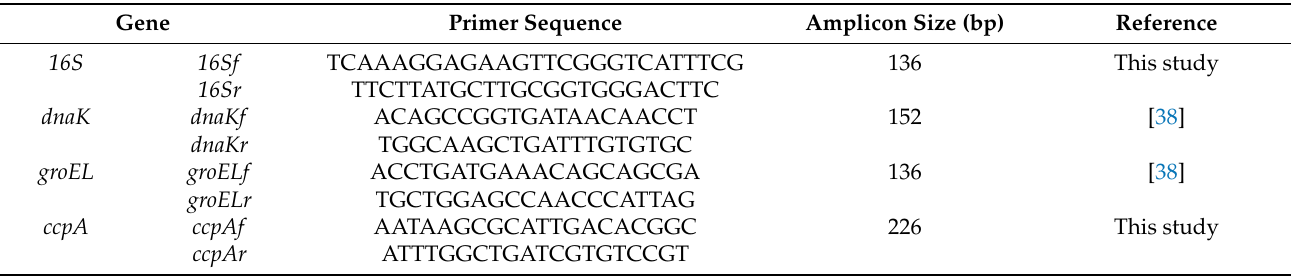
Table 1. Primer sequences used for the in vitro gene expression